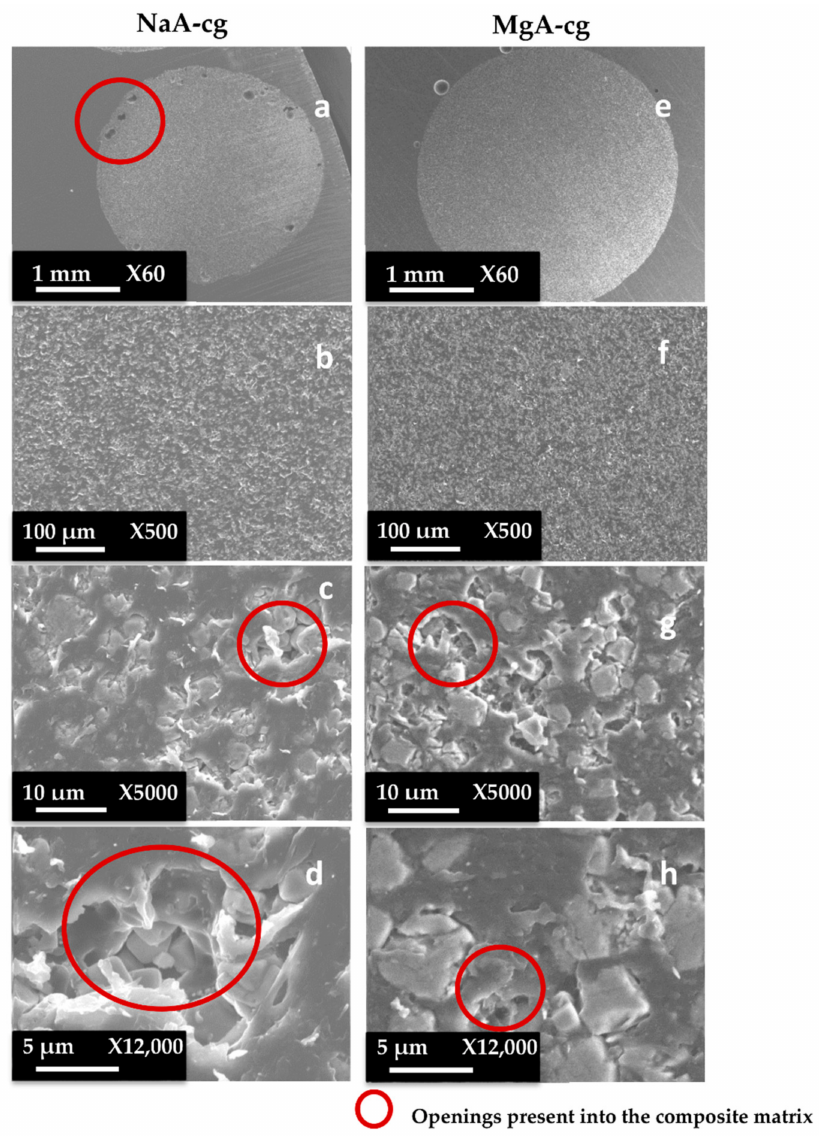
Figure 7. SEM images at different magnifications of ( a – d ) NaA-0-cg and ( e – h ) MgA-1-cg